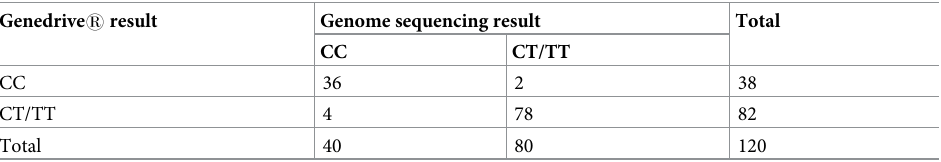
Table 3. Comparisons between Genedrive buccal swab and genome-wide genotyping: CC vs.